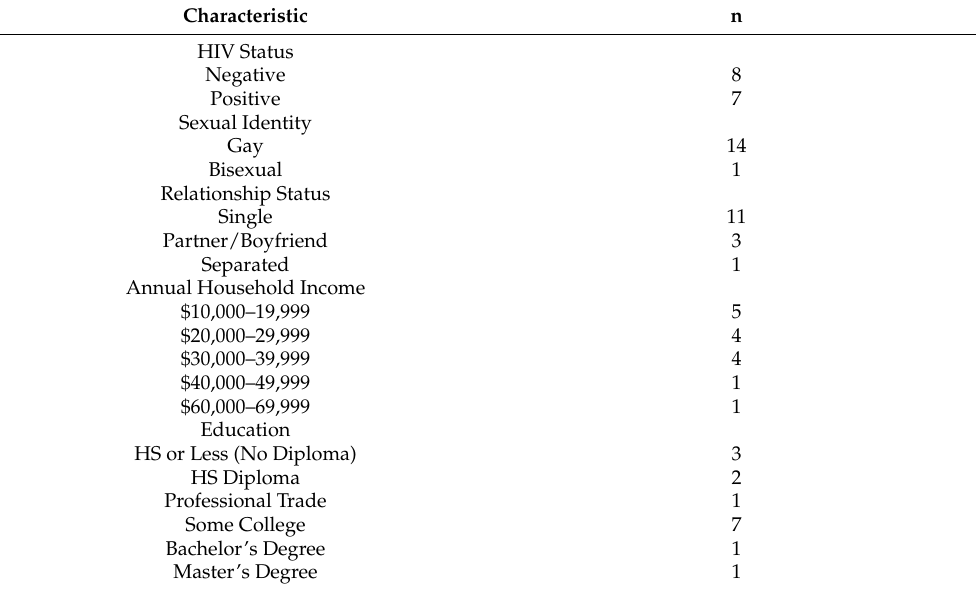
Table 2. Participant demographics of Mexican cisgender males (Mean age = 24.8) in San Antonio, TX, US.